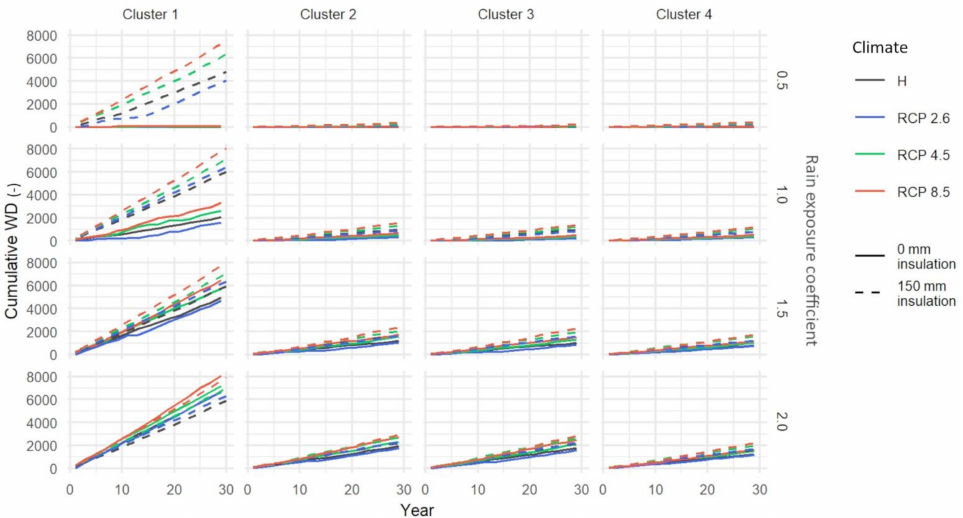
Figure 9. Cumulative WD for the 300 mm masonry wall at the SW orientation for the historical period (H) and RCP